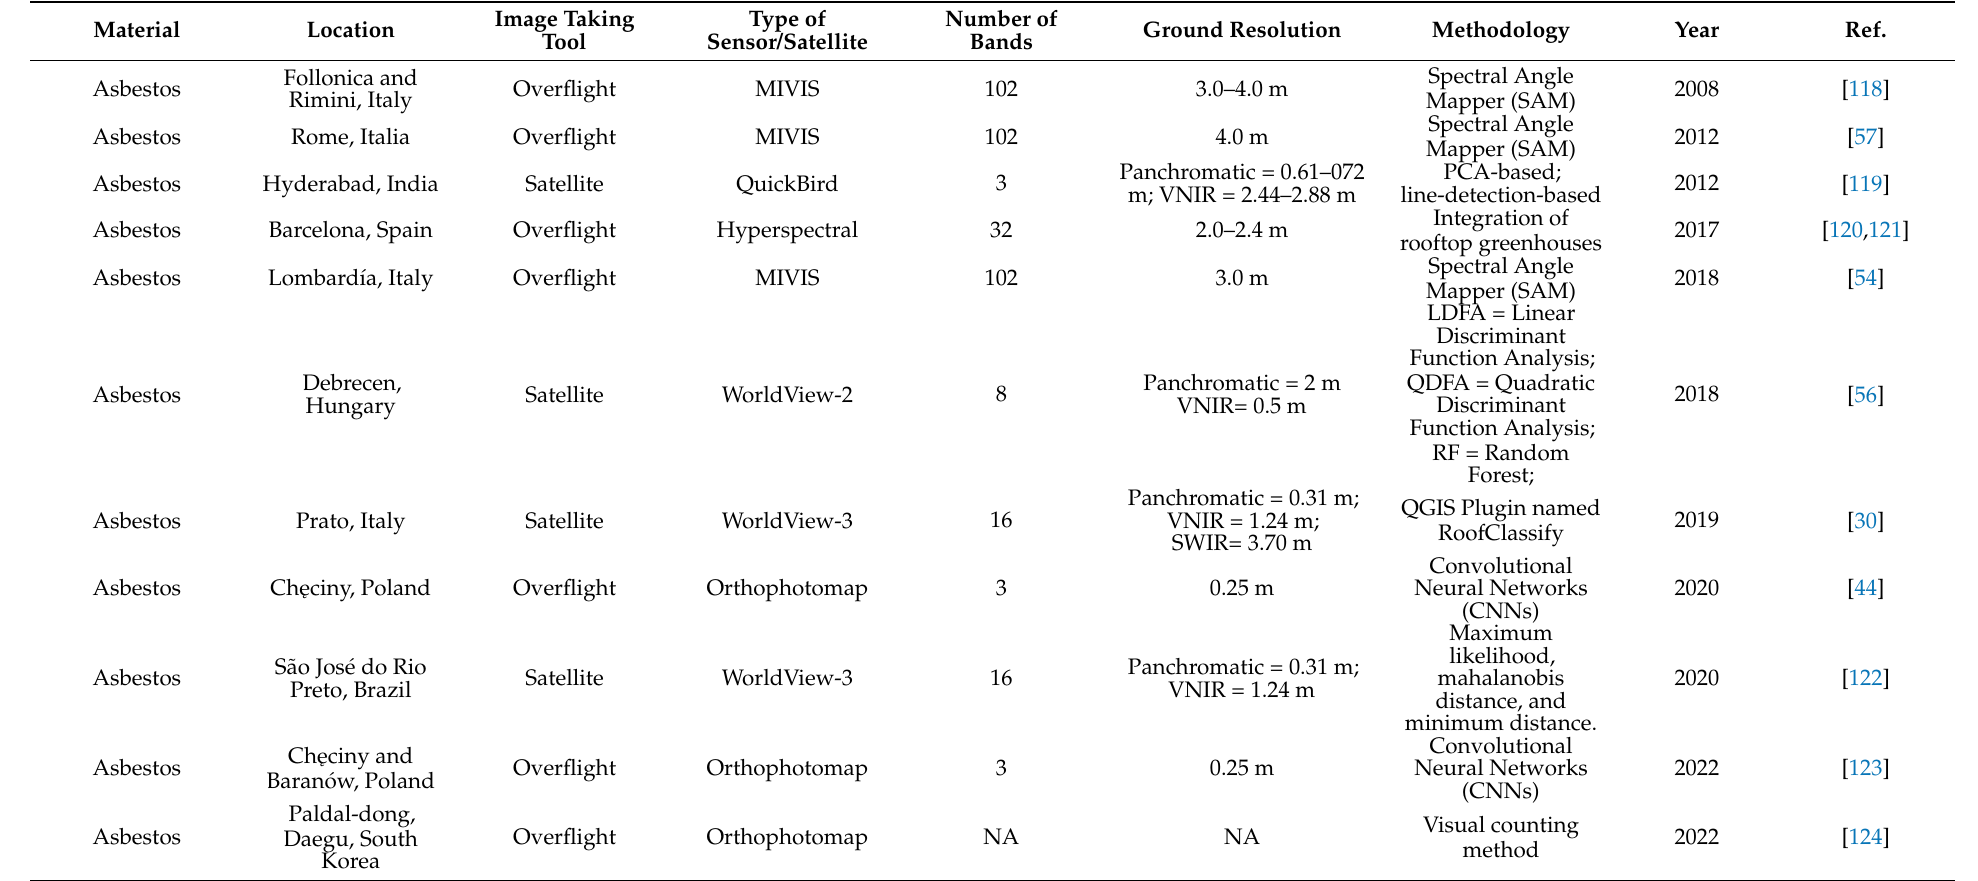
Table A1. The most relevant studies for asbestos roofing identification, oil and gas, and geology related to remote sensing found in literature in the last decade, identified by relevance and organized in increasing order by